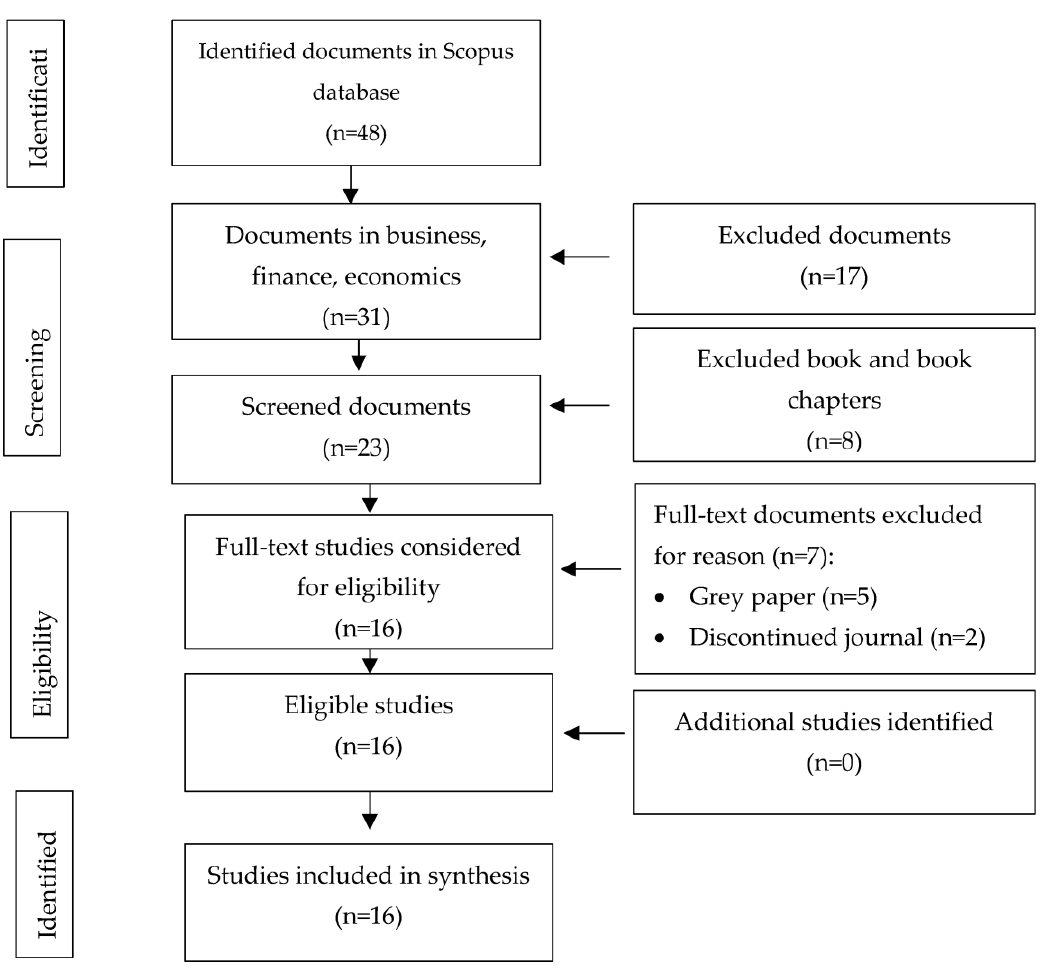
Figure 1. Document Selection .